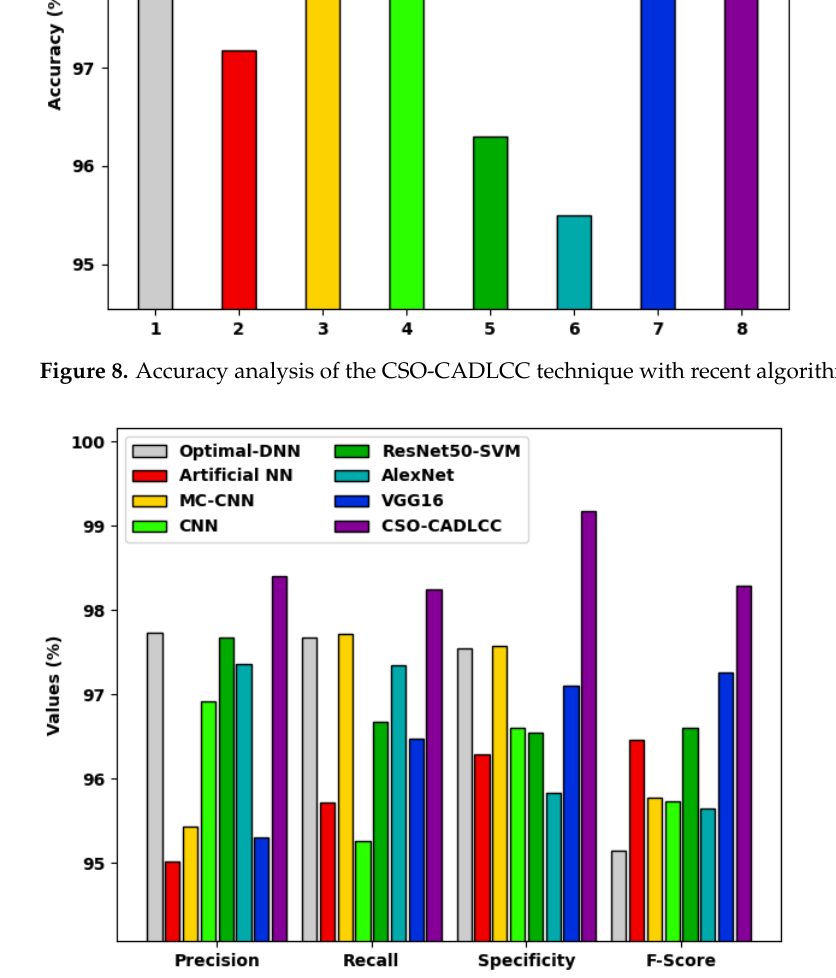
Figure 9. Comparative analysis of the CSO-CADLCC technique with recent algorithms.